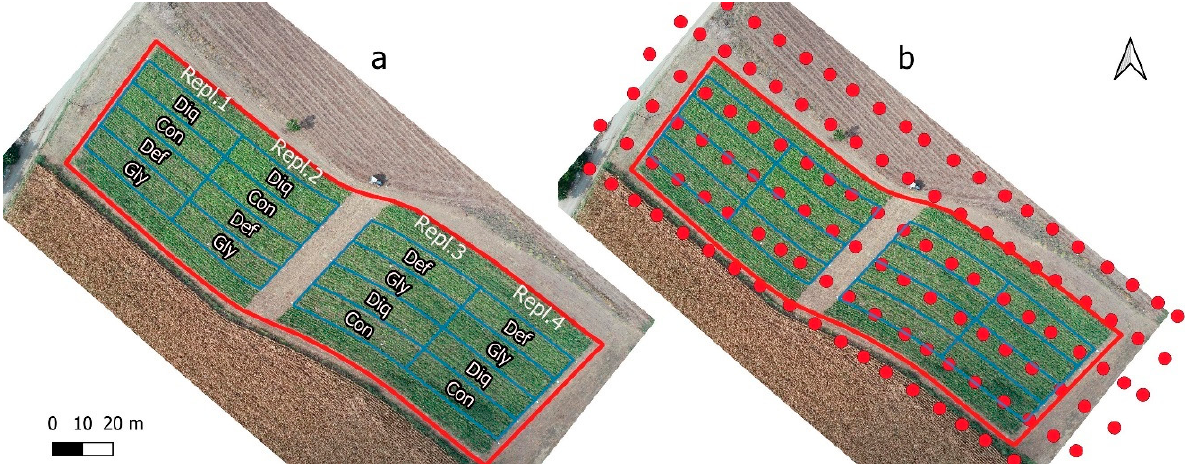
Figure 1. ( a ) The experimental field (aerial view from 27 August 2021) with the four treatments (GLY = Glyphosate, DEF = Spotlight ® , DIQ = Diquat and CON = Control) and the four replications and ( b